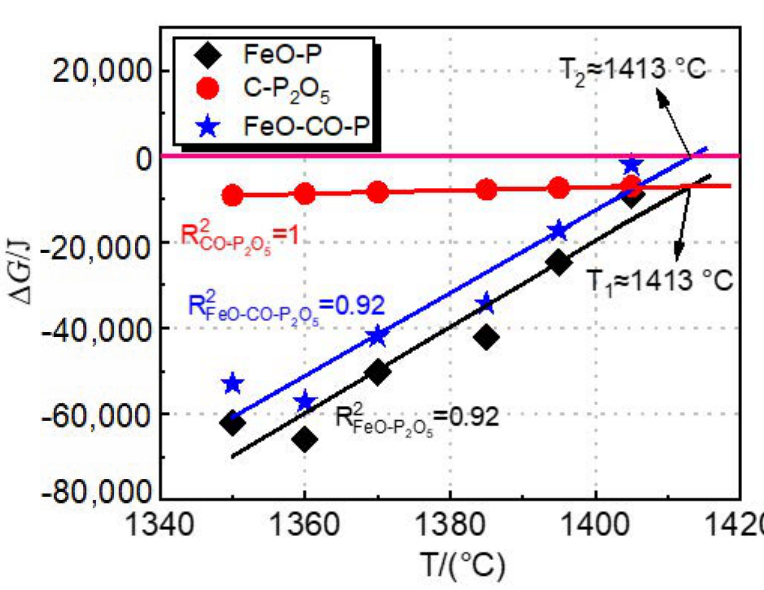
Figure 12. Effect of dephosphorization endpoint temperature on the actual Gibbs free energy changes of FeO-P, C-P 2 O 5 , and FeO-CO-P